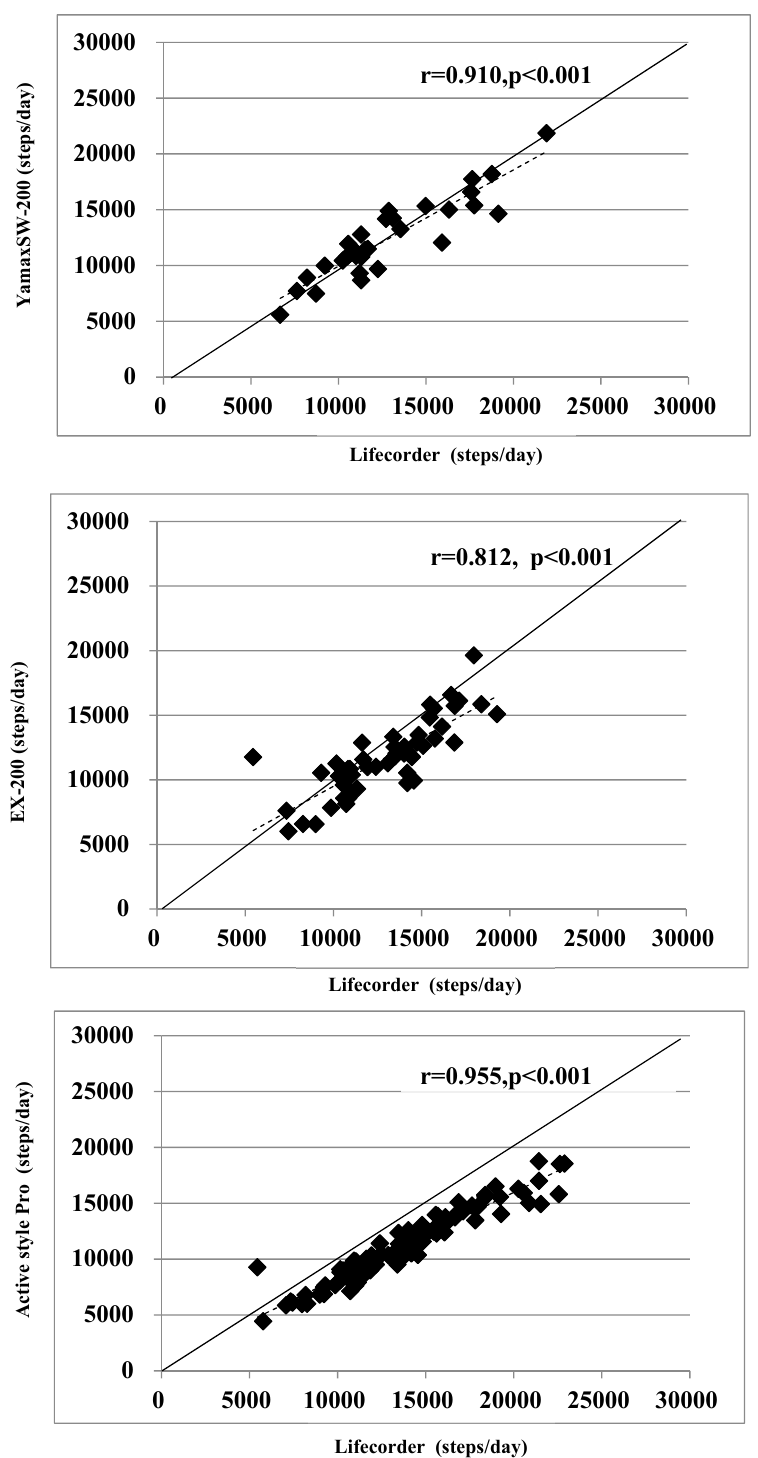
Figure 1. Comparison of step counts recorded by the four pedometers (solid line: identity line, dotted line: regression